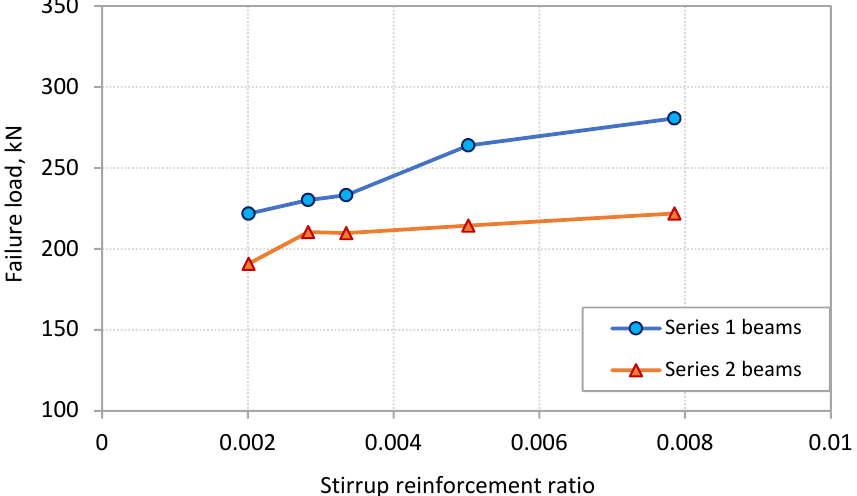
Figure 6. Effect of stirrup reinforcement ratio on PE debonding capacity.